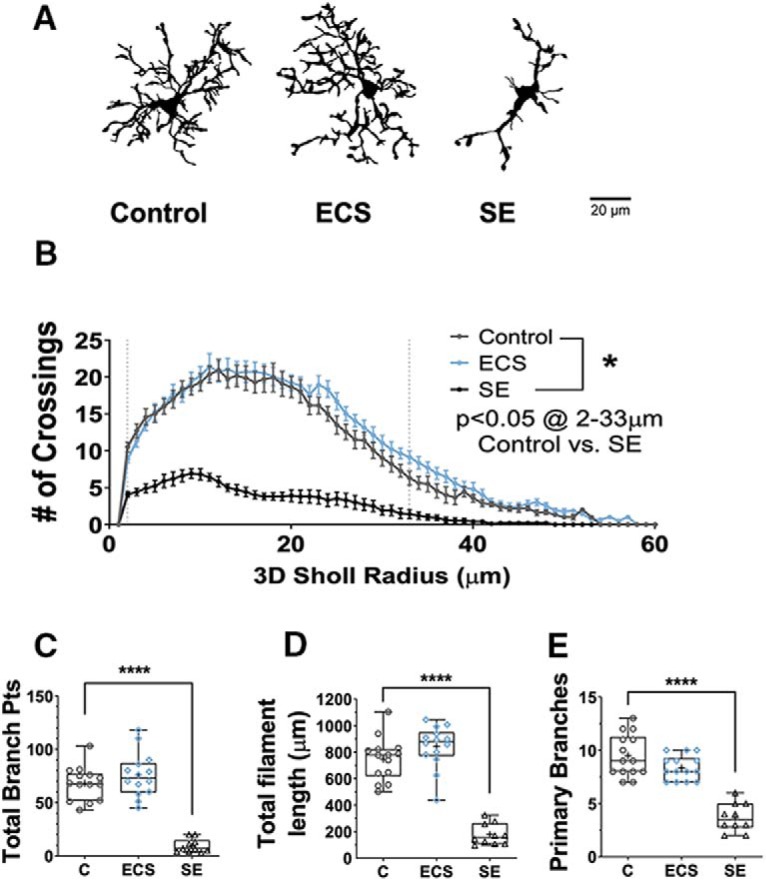
Unlike SE, ECS did not cause morphologic activation of CA1sr microglia. A, Representative binarized images of individual traced microglia from control, ECS or SE animals. B, SE, but not ECS, significantly decreased the number of 3D Sholl crossings in hippocampal microglia (for radii between 2 and 33 μm). C, SE significantly decreased the total number of branch points per cell, while ECS had no significant effect. D, SE significantly decreased the total filament length per cell, while ECS had no significant effect. E, SE significantly decreased the average number of primary branches, while ECS had no significant effect. *p < 0.05, ****p < 0.0001.